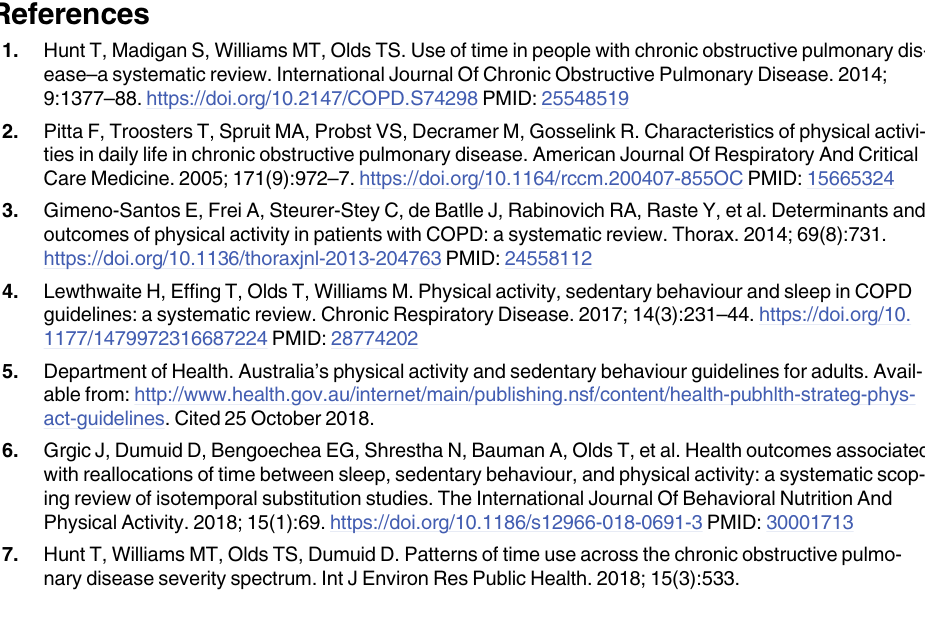
S2 Fig. ‘ One-for-remaining’ models: effect on a) breathlessness unpleasantness; b) depres- sion; and c) fatigue when re-allocating time to each MARCA activity ‘superdomain’, by taking the time from the remainder of the composition. EE, energy expenditure; ES, effect size; LPA, light physical activity; MVPA, moderate to vigorous physical activity; S, sleep; SB, sedentary behaviour. Change ( Δ ) in outcome is presented as standardised effect